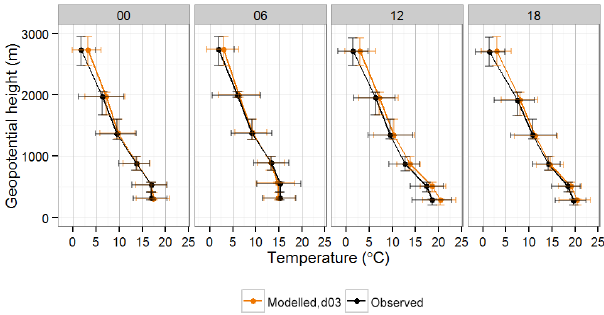
Figure 5. JJA mean profiles of observed and modelled (base run, 1km × 1km horizontal resolution) temperature at Lindenberg at 00:00, 06:00, 12:00 and 18:00UTC. Error bars show the 25th and 75th percentiles of temperature and geopotential